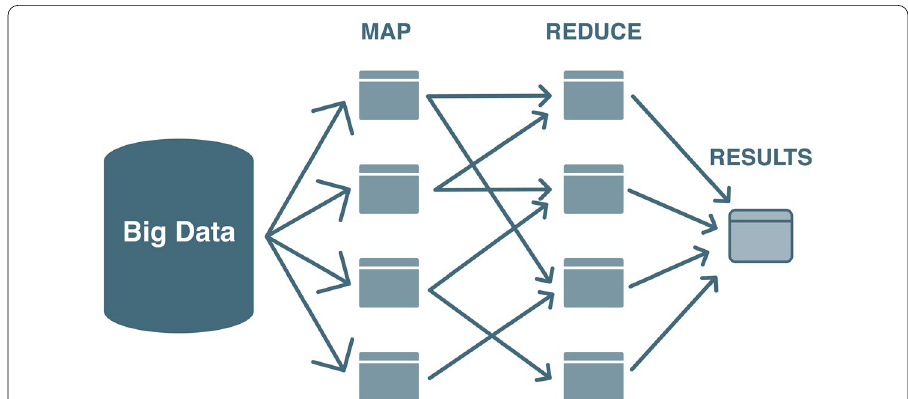
Fig. 4 Architecture of Apache Hadoop